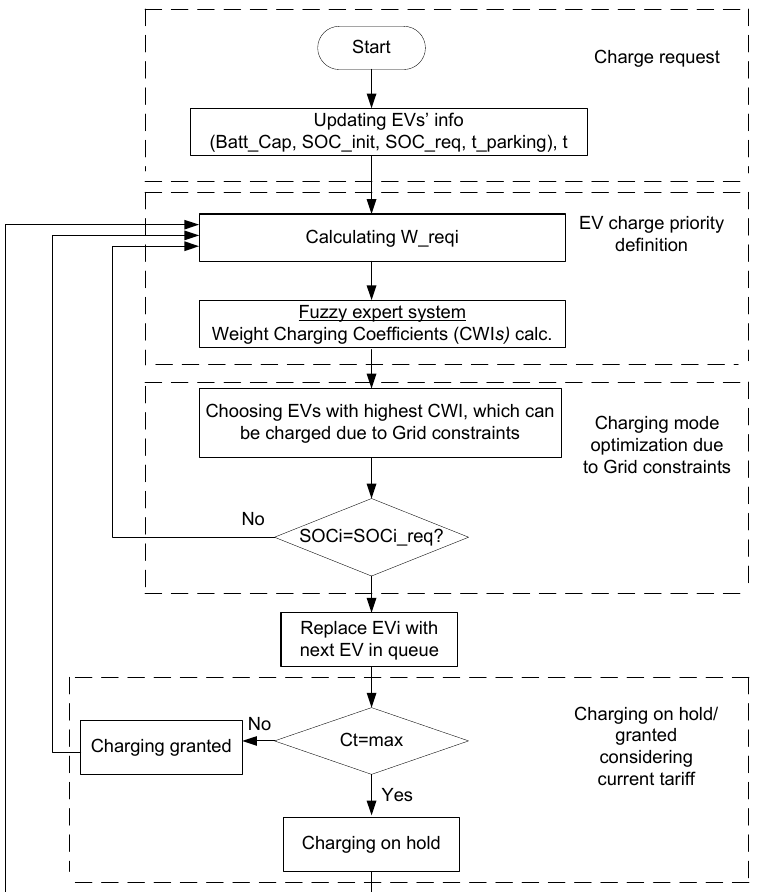
Figure 11. The block diagram of the situational algorithm for controlling the freight EVs charging considering the optimization of the cost of electricity.